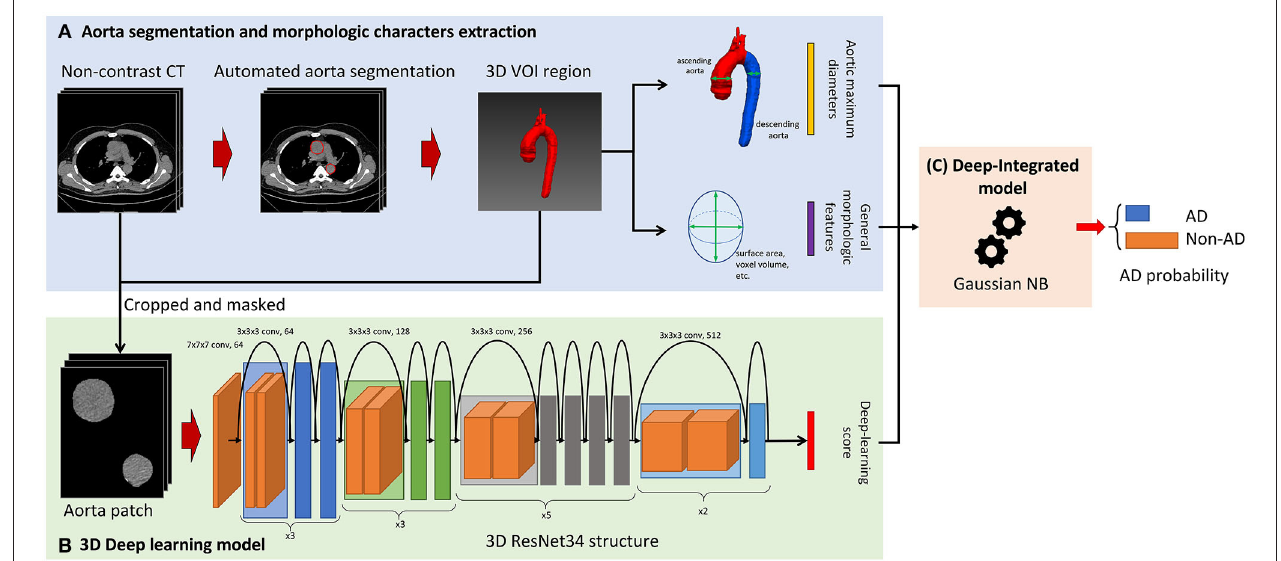
FIGURE 2 | Overview of the model construction for aortic detection. (A) The non-contrast CT images were segmented automatically to obtain the aorta mask. Then, the morphological characteristics were extracted from the aorta mask including the aortic maximum diameters and general morphological features. (B) The input of the three-dimensional (3D) ResNet34 model was cropped and masked by aorta segmentation and the prediction probability of the deep learning (DL) model was used as the DL score. (C) The deep-integrated model was based on the Gaussian Naive Bayes (NB) algorithm and trained on the combination of the DL score and all the morphological characteristics to predict the status of aortic dissection